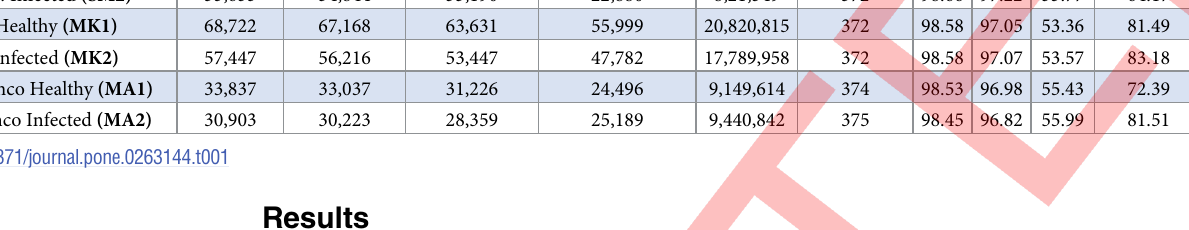
Table 1. Data processing and QC (quality control) stats of citrus ( C . aurantifolia , C . paradisi , C . reticulata Blanco) samples. Sample abbreviations used in this